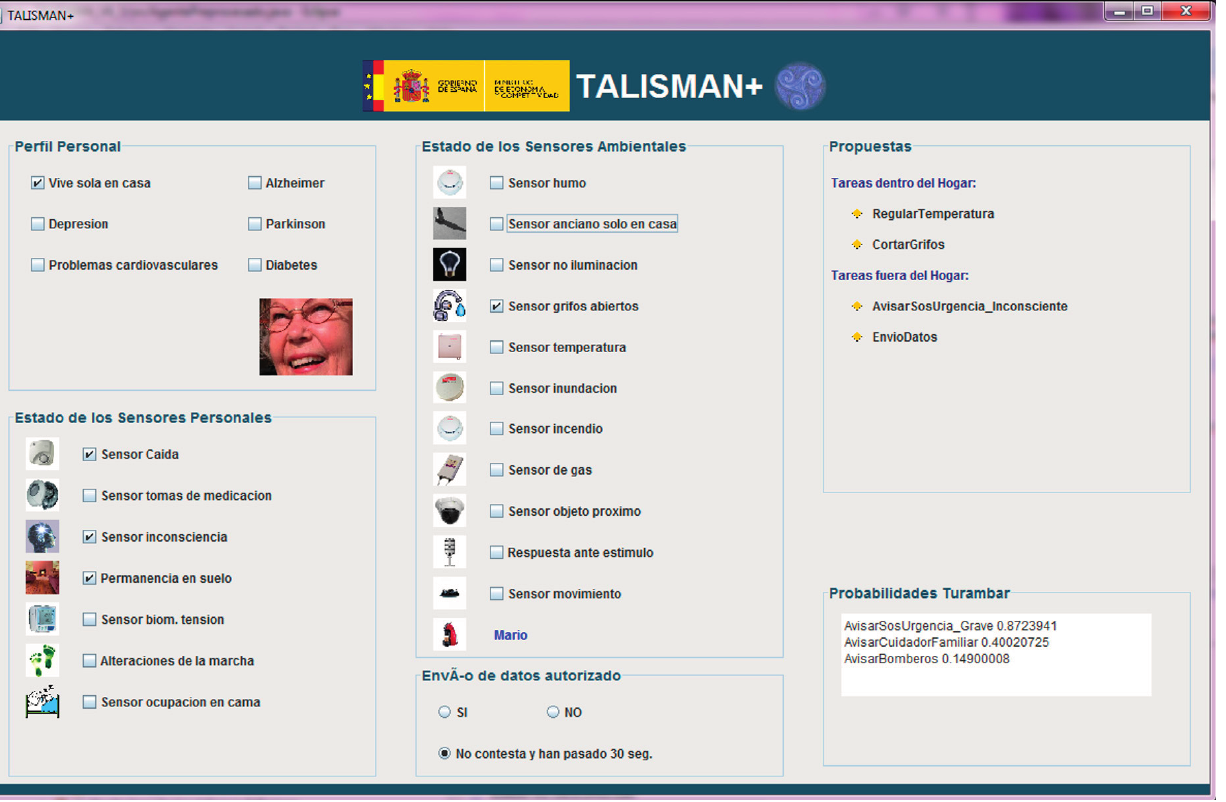
Figure 10. Representation of data for local and hybrid TALISMAN+ reasoners in the Smart